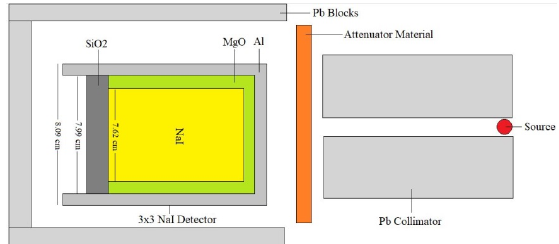
Figure 1: Schematic diagram of the modeled NaI (Tl) detector with simulation